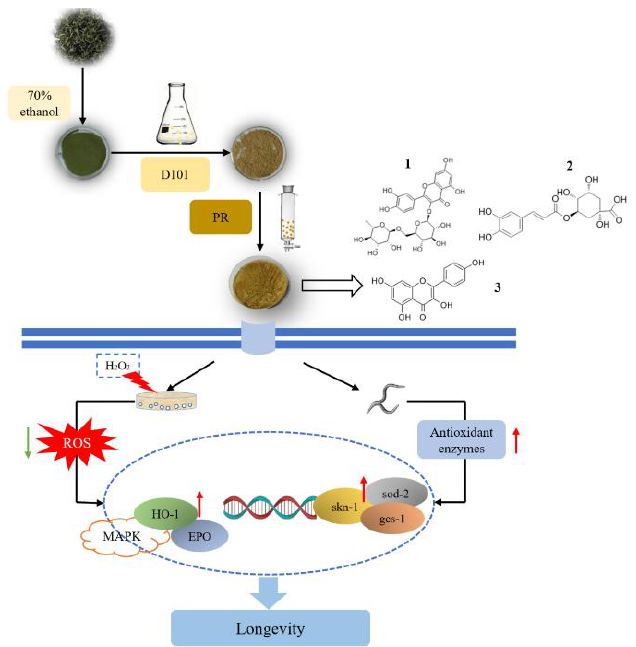
Figure 7. Anti−oxidation and anti−aging molecular mechanism of LBLF. 1−rutin, 2−chlorogenic acid, Figure 7. Anti-oxidation and anti-aging molecular mechanism of LBLF. 1-rutin, 2-chlorogenic acid, 3−kaempferol.